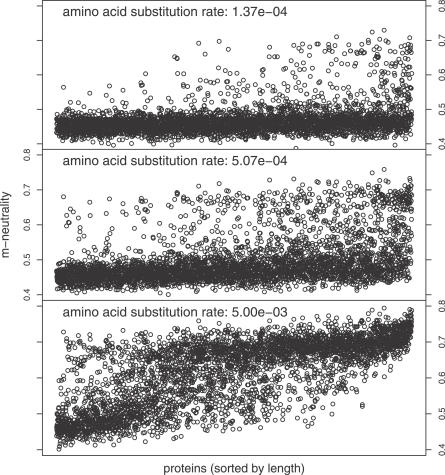
m-neutralities, vi, After Selection for Three Different Amino Acid Substitution Rates uaa
The data points are sorted according to the length of the proteins. The increased effectiveness of selection for higher m-neutralities in large proteins for high amino acid substitution rates is clearly visible.